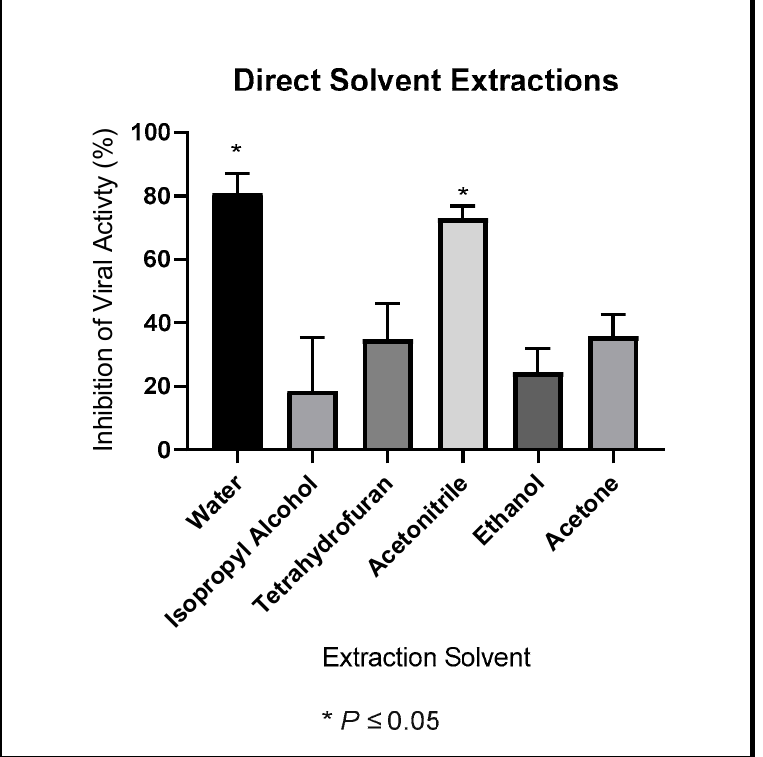
Figure 2. Dried M. balsamina leaves were extracted into water, isopropyl alcohol, tetrahydrofuran, acetonitrile, ethanol, and acetone. We used the extracts to treat cells infected with 1 ng of HIV-1 NL4-3 . We show the average antiviral inhibitory effects. Table 3. Tukey’s Multiple Comparisons Test.